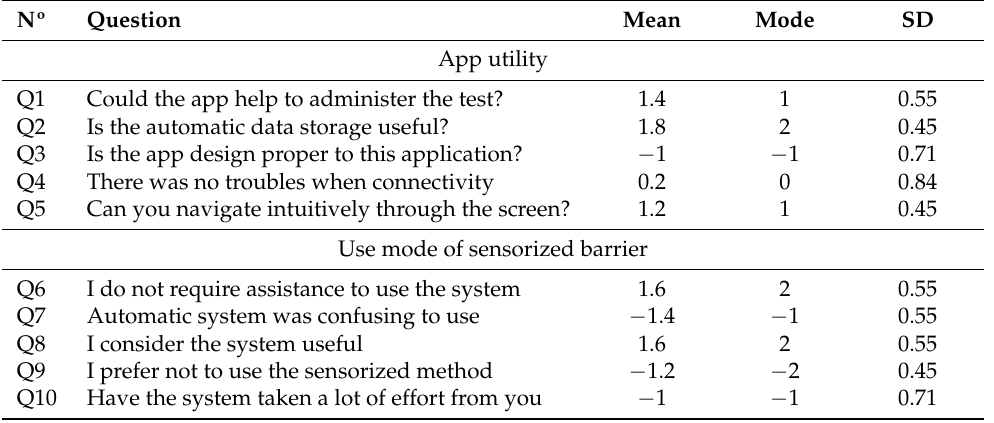
Table 2. Results of the usability